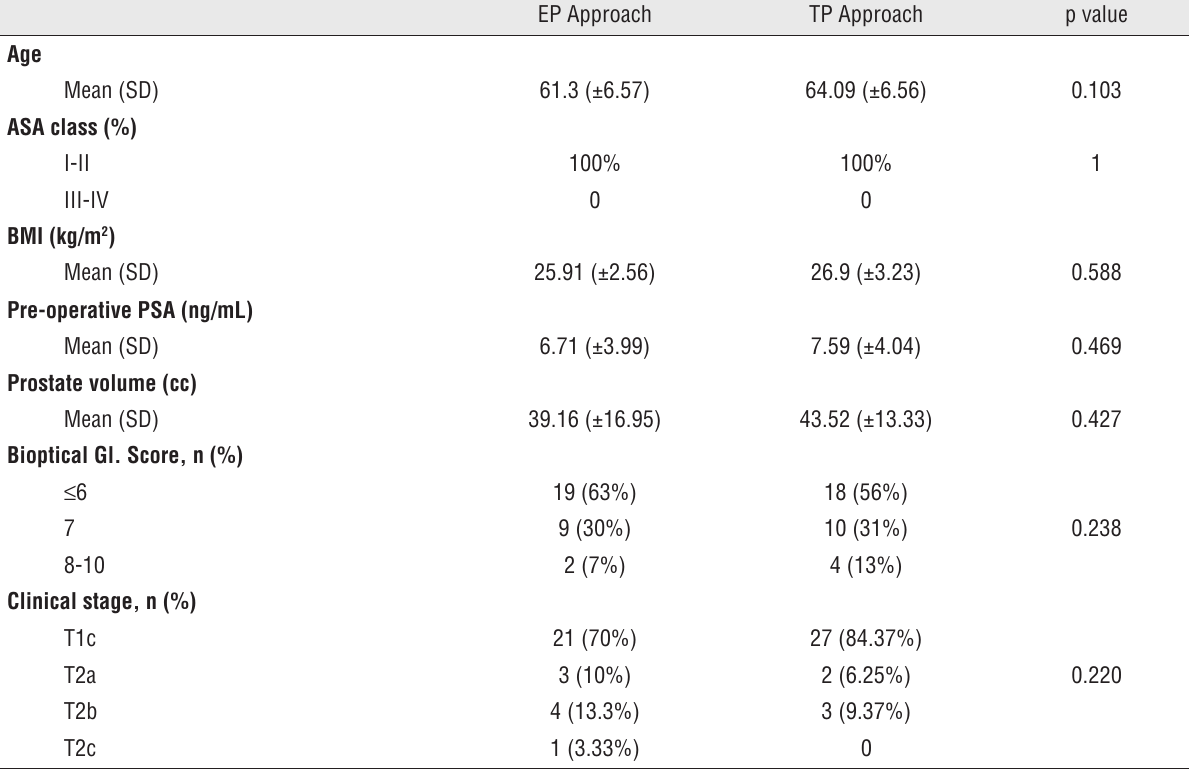
Table 1 - Demographic and clinical characteristics of extra-peritoneal and transperitoneal robot-assisted radical